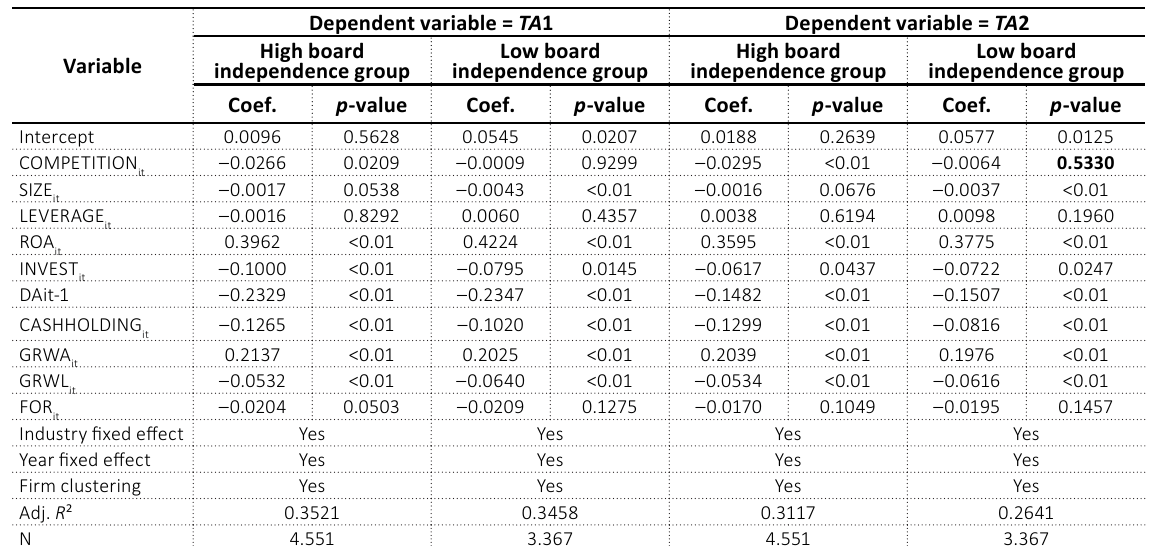
Table 5. The effect of board independence on the relationship between product market competition and tax avoidance